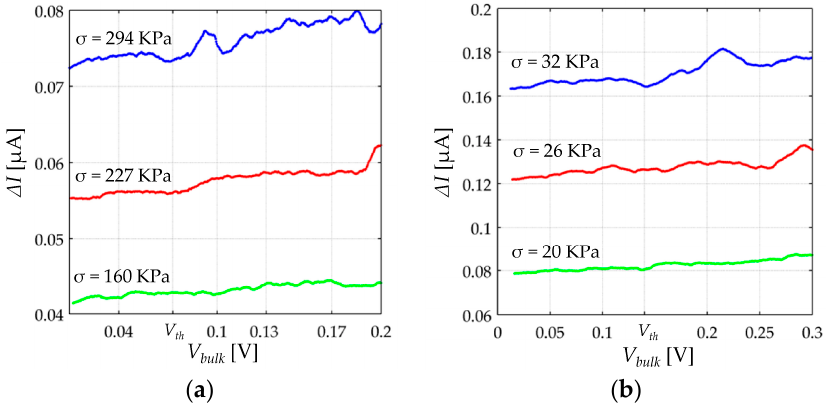
Figure 14. Plots for ∆ I [ n ] as a function of V bulk [ n ] at different stresses for the sensors: ( a ) FlexiForce A201-1 and ( b ) Interlink FSR 402. V th is determined by detecting the slope change of ∆ I [ n ].